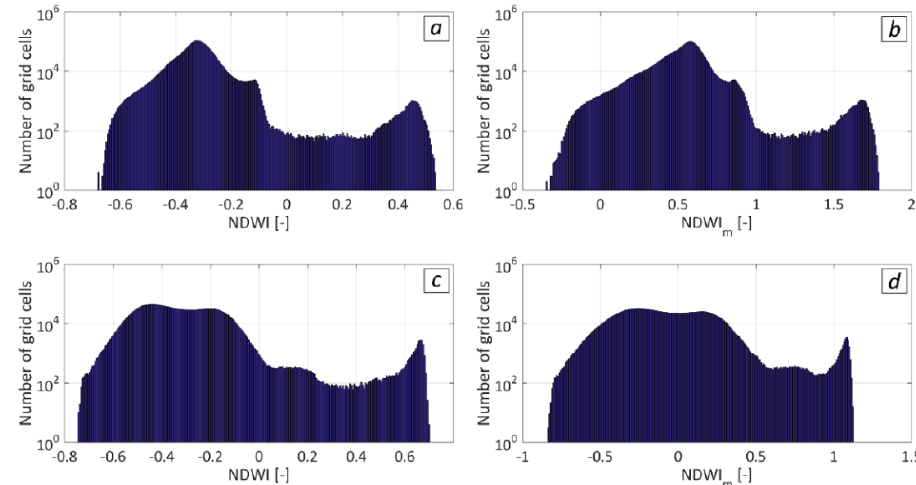
Figure 9. Frequency histograms: ( a ) NDWI for 17 June 2017; ( b ) NDWI m for 17 June 2017; ( c ) NDWI for 17 February 2019; and ( d ) NDWI m for 17 February 2019. The semilogarithmic plot highlights a bimodal distribution, where the two peaks represent water and soil grid cells. The water area in the image is significantly smaller than the non-water area,